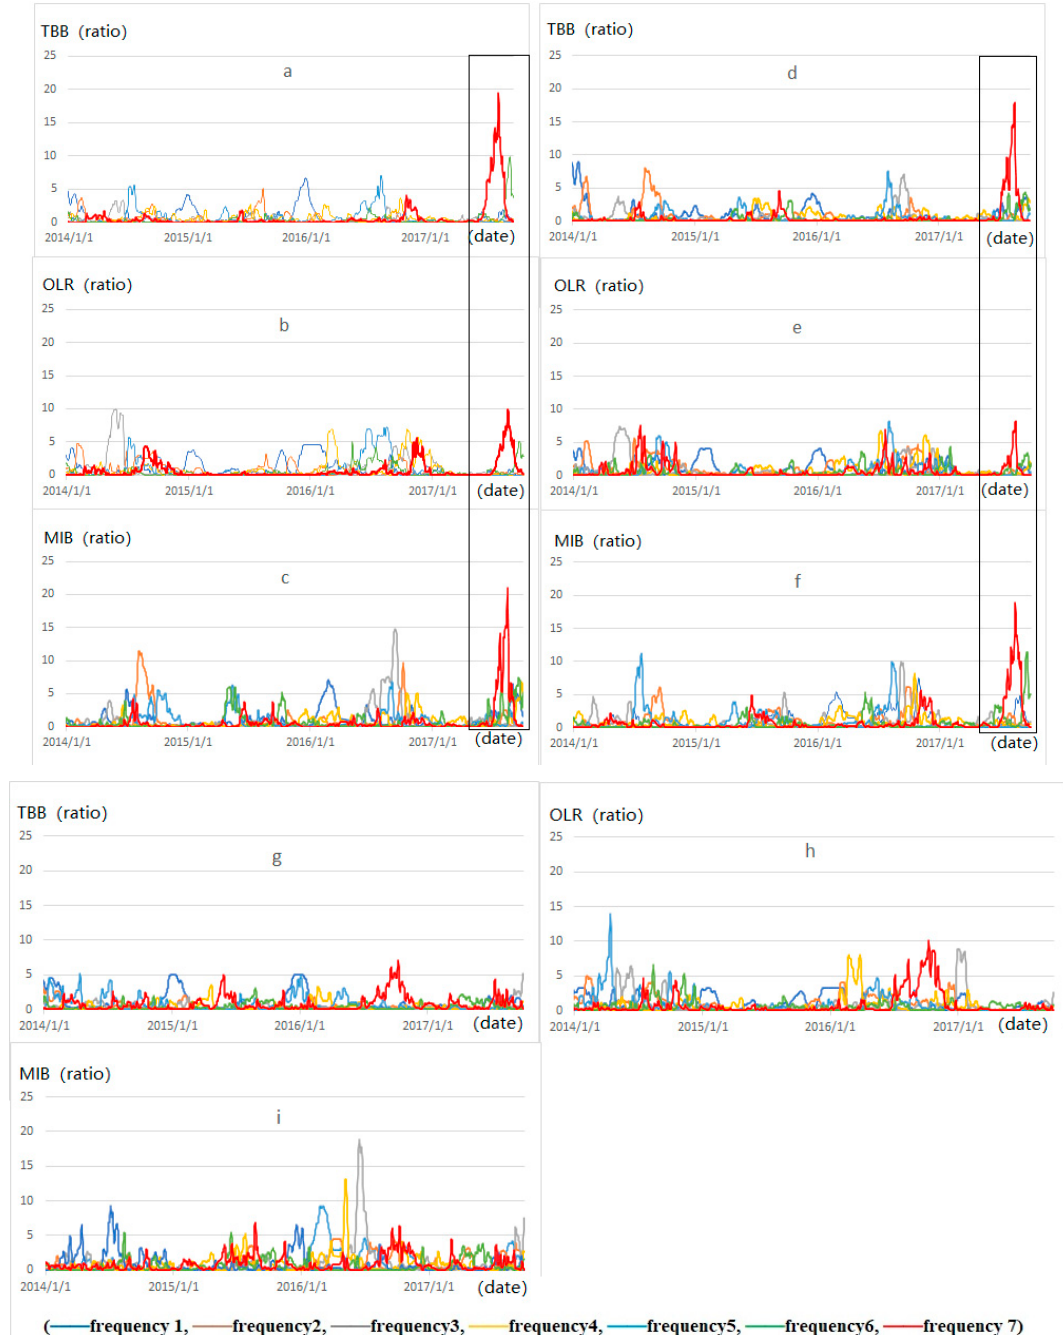
Figure 5. Power spectra time series for full frequency bands in the study region from 1 January 2014 to 30 September 2017. Power spectra of ( a ) temperature of brightness blackbody (TBB), ( b ) outgoing longwave radiation (OLR), and ( c ) medium-wave infrared brightness (MIB) in Region 1; power spectra of ( d ) TBB, ( e ) OLR, and ( f ) MIB in Region 2; power spectra of ( g ) TBB, ( h ) OLR, and ( i ) MIB in the epicentral region.